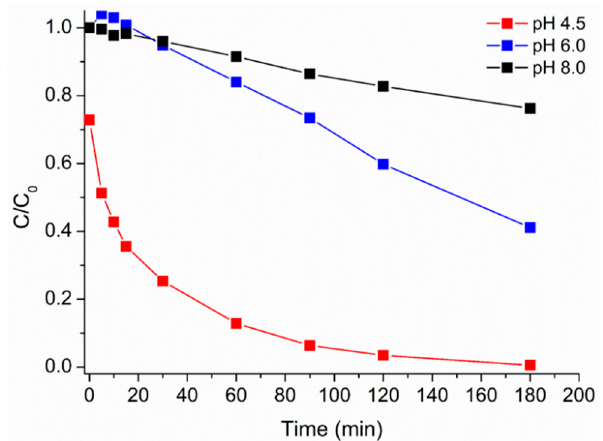
Figure 6. Caffeine relative photodegradation vs. irradiation time at different initial pH values: 4.5 (red squares), 6.0 (blue squares), and 8.0 (black squares) MH0.2 200 mg·L − 1 , H 2 O 2 1.50 × 10 − 3 M. Data reported considering an initial caffeine concentration of 5 mg·L − 1 .